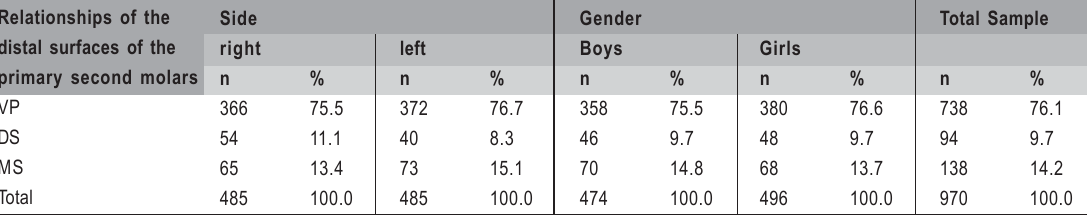
Table 1. Distribution of the relationships of the distal surfaces of the primary second molars, expressed in number (n) and percentage (%), according to side and gender.